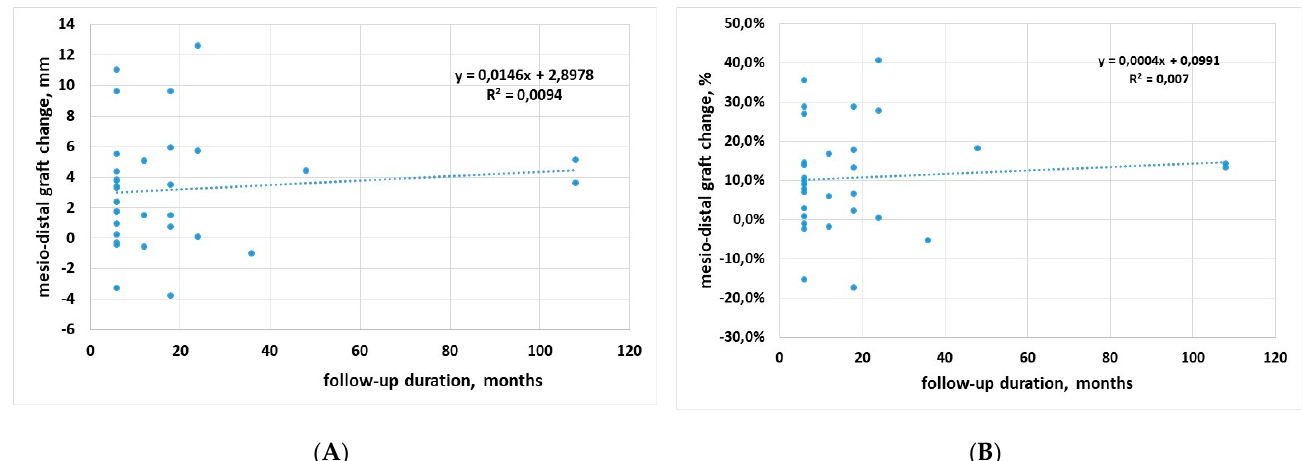
Figure 3. Regression analysis for mesio-distal dimension change against follow-up time. ( A ) data in mm; ( B ) data in percentage.